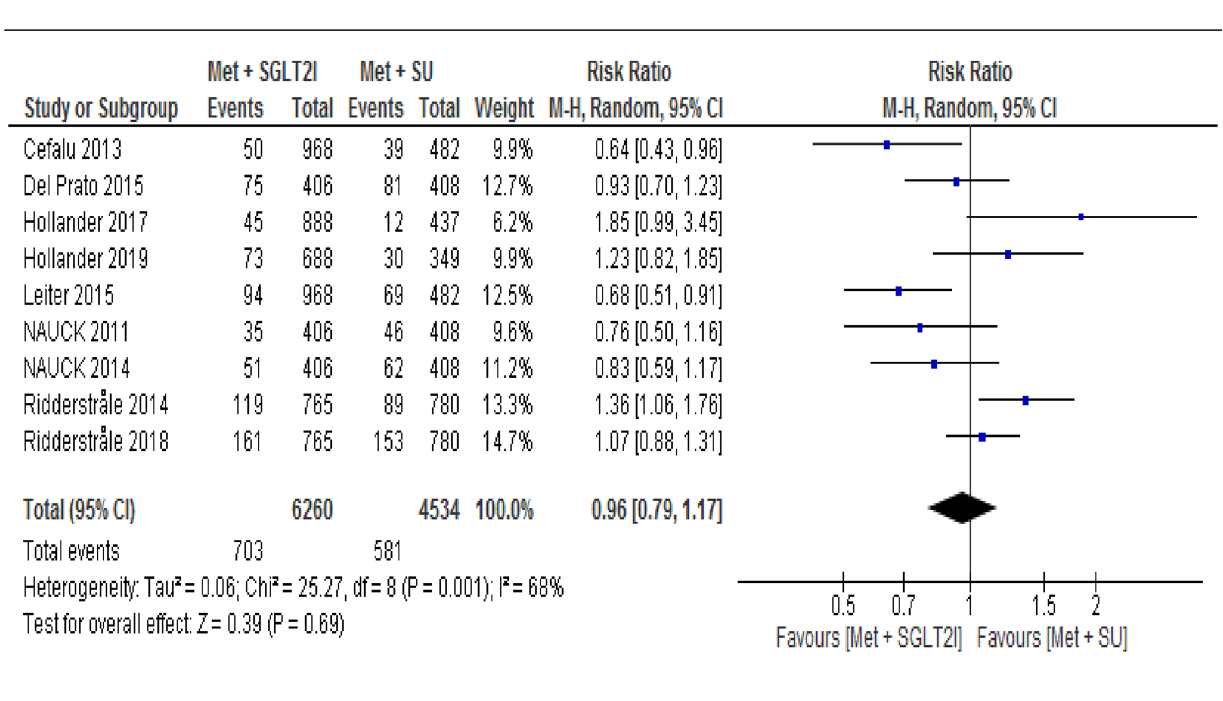
Figure 6. Risk of adverse events between patients who were on metformin-SGIT2I and metformin- sulphonylureas combination therapies. RR risk ratio; CI confidence interval; df degrees of freedom; Met metformin; SGLT2I sodium-glucose co-transporter 2 inhibitor; SU sulfonylurea.